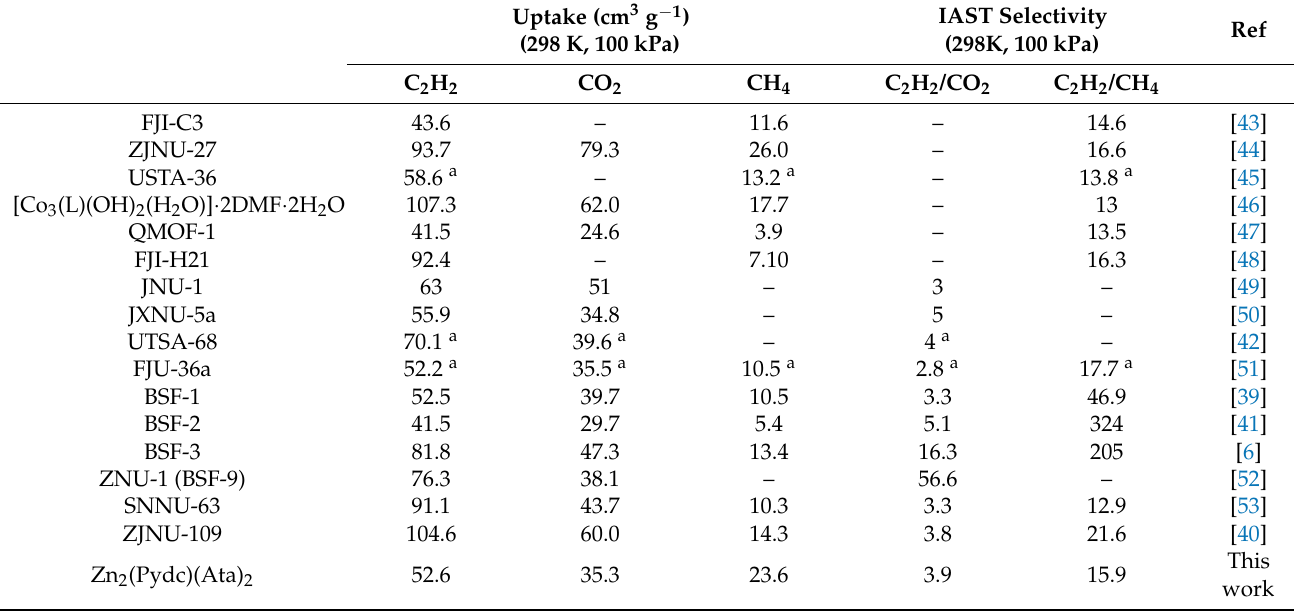
The Q st values for C 2 H 2 , CO 2 , and CH 4 at a near ‐ zero loading in 1 were calcu ‐ lated to be 43.1, 32.1, and 22.5 kJ mol − 1 , respectively (Figure 4A). These values were